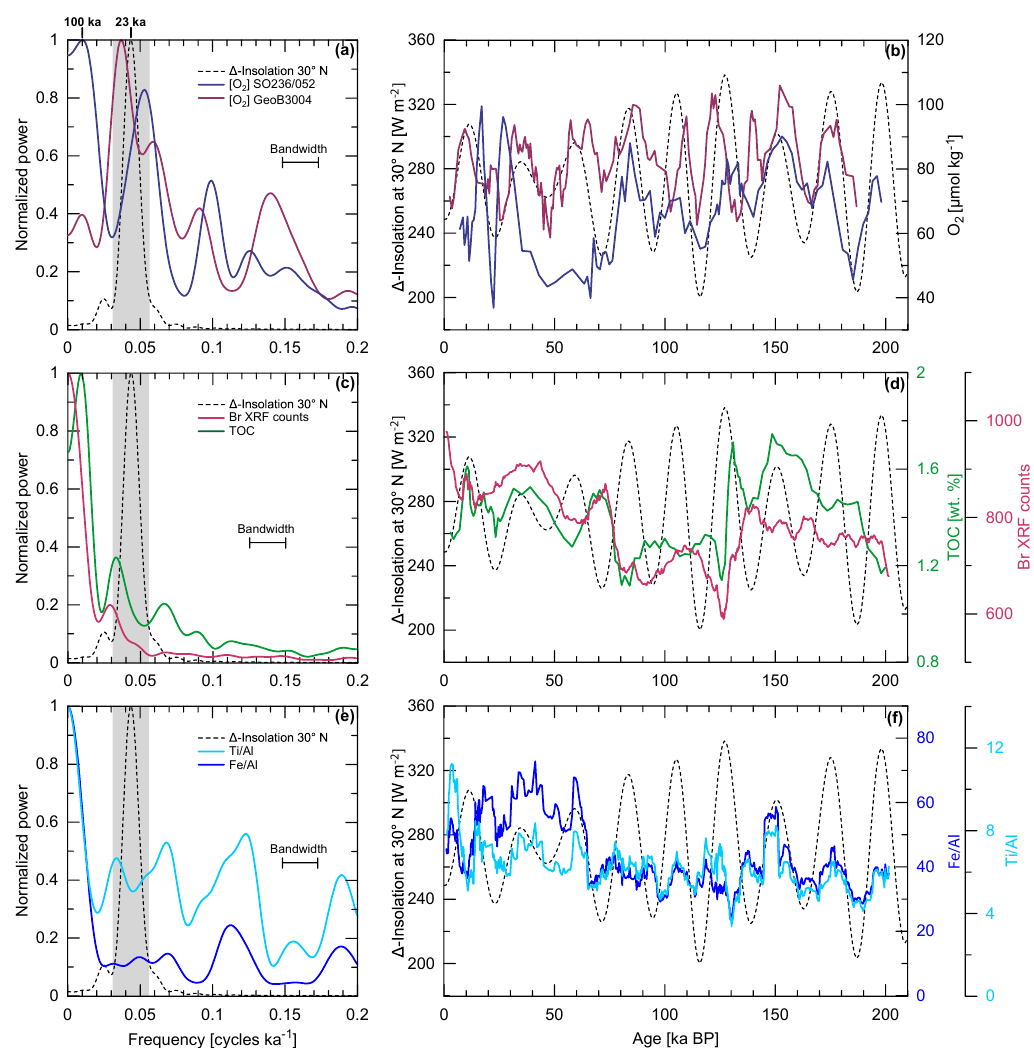
Figure 4. Records and normalized Blackman–Tukey power spectra of (a, b) the oxygen reconstructions of core SO236-052-4 (blue) and GeoB3004 (purple), (c, d) productivity proxies TOC (green) and Br XRF counts (pink), and (e, f) dust proxies Ti / Al (light blue) and Fe / Al (dark blue) in comparison to the (cid:49) -insolation at 30 ◦ N (black dashed line). Grey bars indicate the 23kyr period of the (cid:49) -insolation and its bandwidth. Oxygen and TOC records represent 5-point running averages; Br XRF counts and Ti / Al and Fe / Al records represent 15-point running